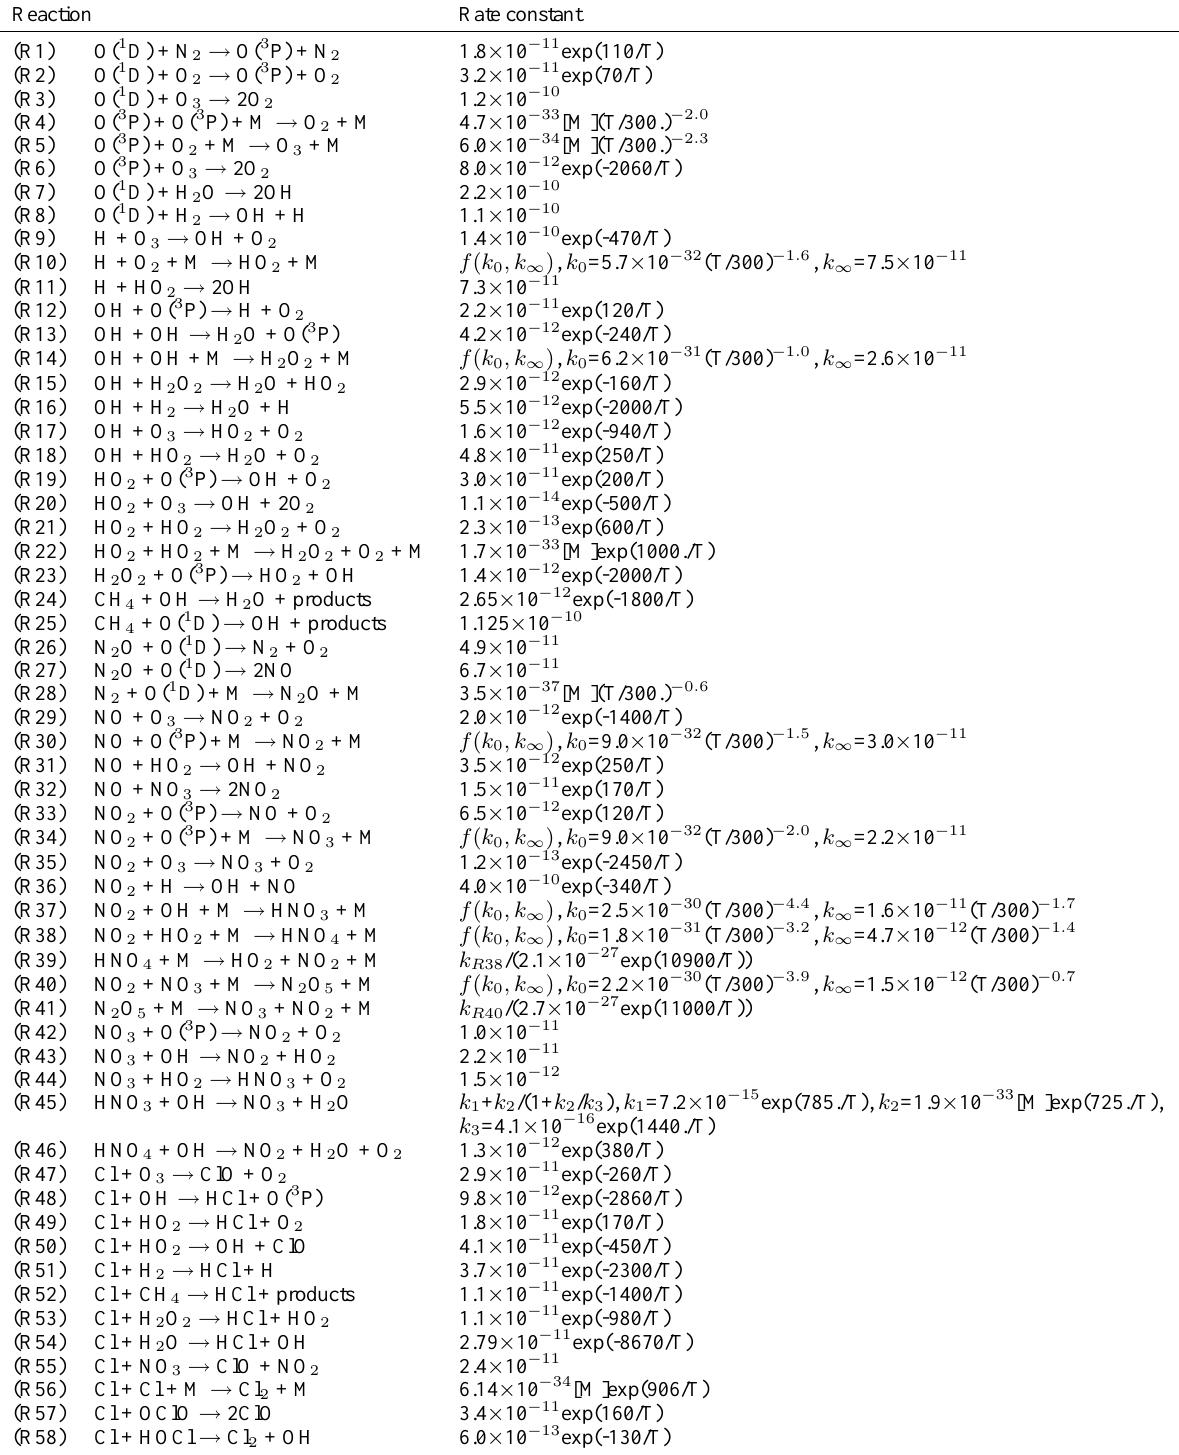
Table 3. Gas phase reactions included in the model. Rate constants for first- and second-order reactions are given in units of s − 1 and molecules − 1 cm 3 s − 1 , respectively. Rate constants for third-order reactions are given as effective second-order rate constants in units